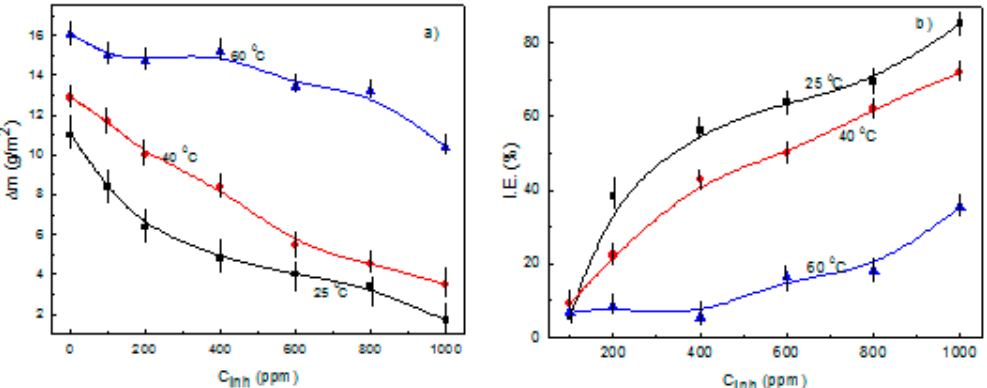
Figure 2. Effect of α -linolenic acid concentration on the ( a ) weight loss and ( b ) inhibitor efficiency for carbon steel in 0.5 M H 2 SO 4 at different temperatures.